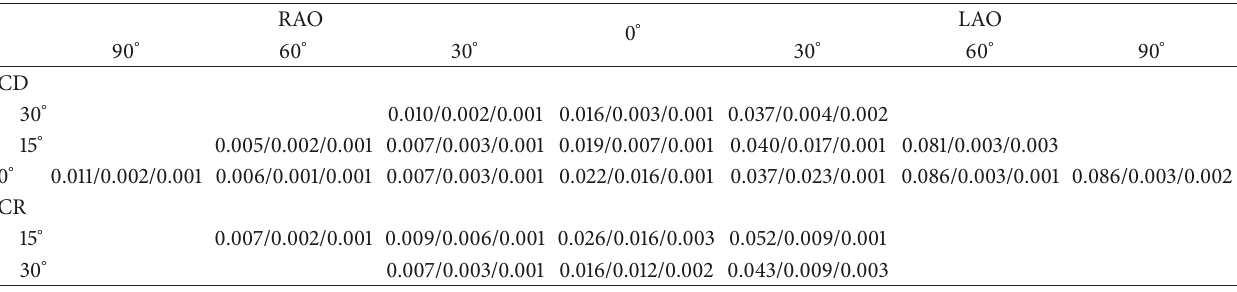
Table 3: Dose from scatter radiation normalized to 𝑃 KA ( 𝜇 Gy/ 𝜇 Gy ∗ m 2 ) for cardiology (in each cell dose without the use of shielding, with shielding placed close to the patient and with shielding placed close to the physician). RAO 0 ∘